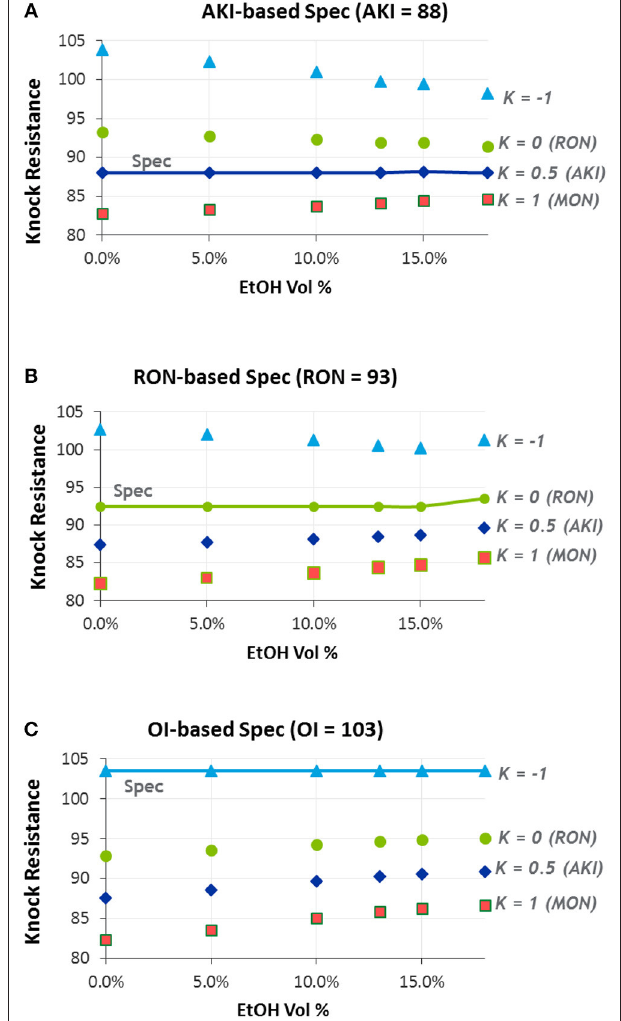
FIGURE 7 | Knock resistance of gasoline produced via 3 different specification methods, at varying ethanol concentrations, under different engine K parameters. Refinery blending of the fuel is done assuming that K is (A) + 0.5, (B) 0, and (C) −